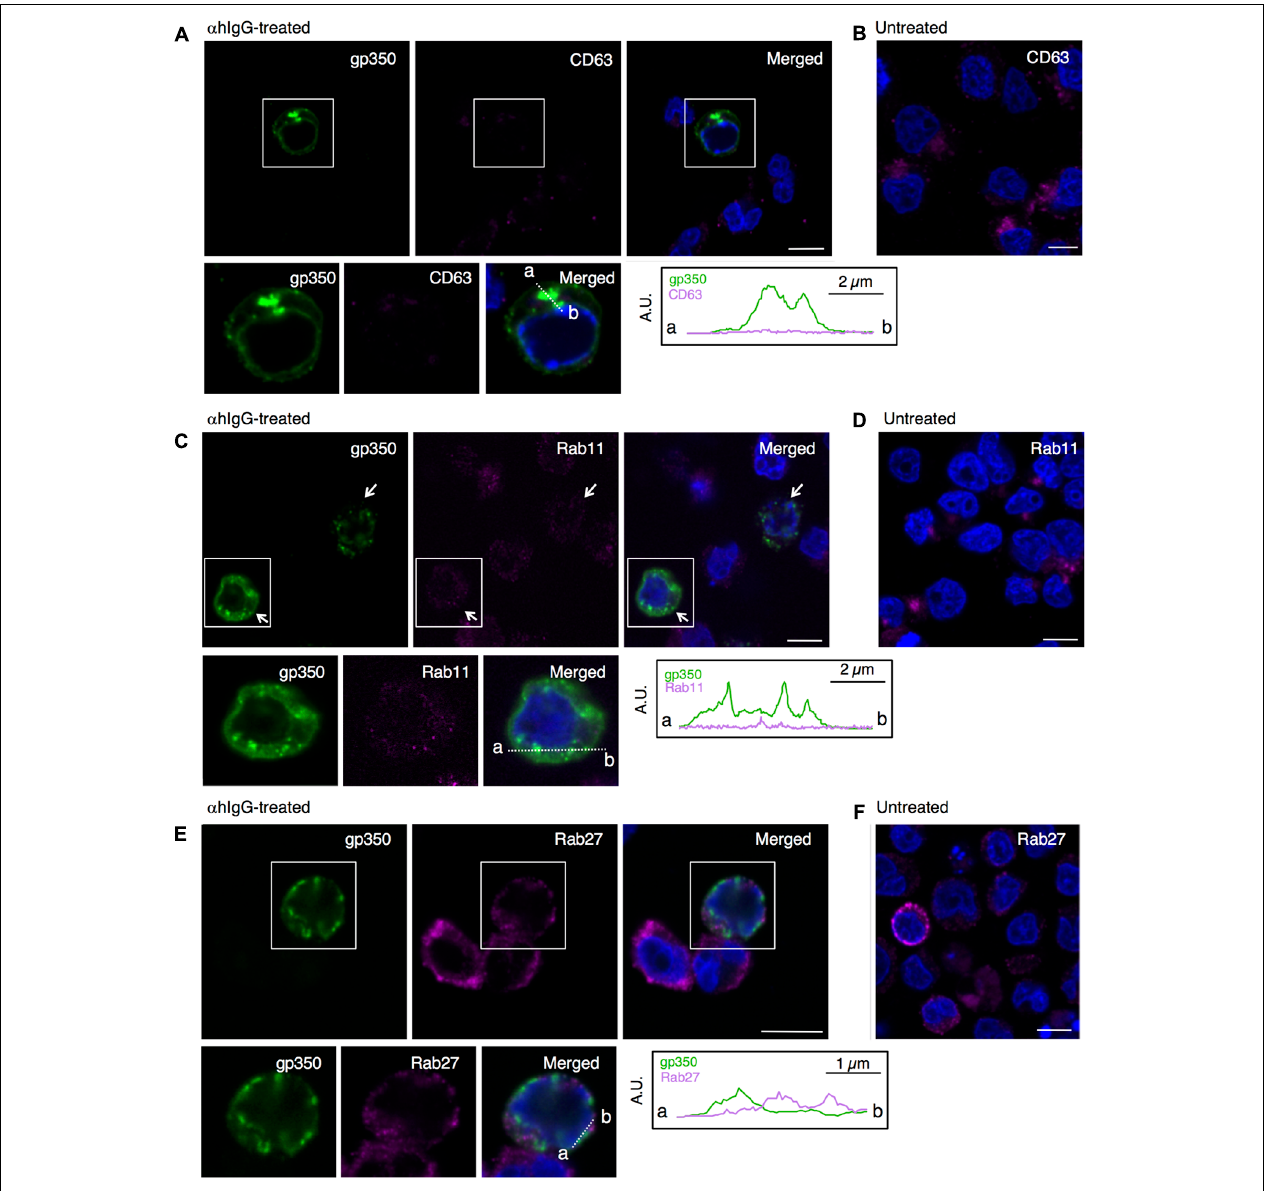
FIGURE 6 | EBV glycoprotein does not colocalize with endosomal markers. The distribution of the EBV glycoprotein and markers of endosomes in Akata + cells induced into the lytic cycle. Akata + cells were treated with (A,C,E) or without α hIgG (B,D,F) for 16 h. (A) The distribution of gp350/220 (left), CD63 (middle) and merged (right) images are shown. As a control, the distribution of CD63 in the untreated cells is shown in (B) . (C) The distribution of gp350/220 (left), Rab11 (middle) and merged (right) are shown. As a control, the distribution of Rab11 in the untreated cells is shown in (D) . (E) The distribution of the EBV capsid antigen, gp350/220 (left) and Rab27a (middle) and merged (right) images are shown. As a control, the distribution of Rab27a in the untreated cells is shown in (F) . The nuclei (blue) were counterstained with Hoechst 33342. Insets show the boxed areas. The plots indicate the individual fluorescence intensity along each of the corresponding lines. A.U., arbitrary unit. Scale bars: 10 µ